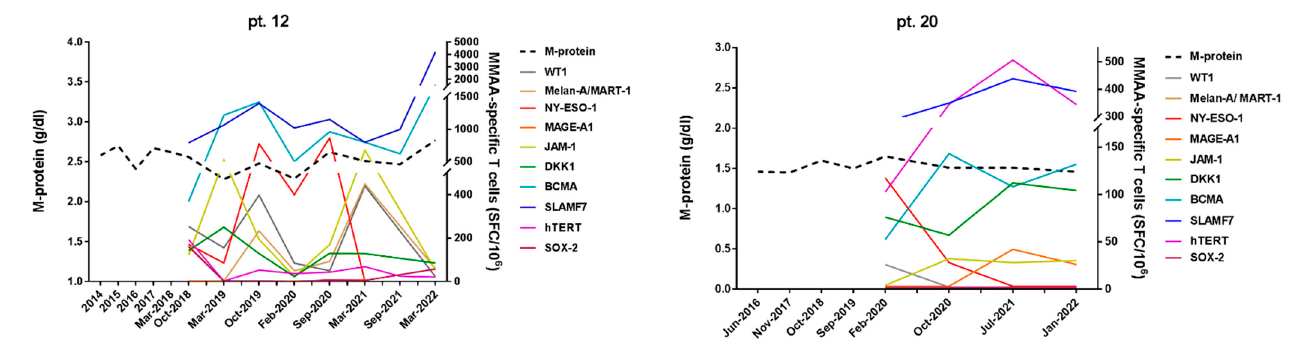
Figure 2. Correlation between MMAA-specific T-cell responses and disease course in two patients with stable monoclonal gammopathy. In these graphs, frequencies of IFN γ -secreting antineoplastic T cells targeting the different MMAAs (right, y -axis; colored continuous lines), as assessed in PB samples, at different time-points of follow-up ( x -axis), are correlated with M-protein levels (left, y -axis; black dotted line). Different y -axis scales are applied in the graphs, according to patient’s dataset. Left panel : a 79-year-old woman (pt. 12), diagnosed with IgG-kappa MGUS (intermediate-high risk) in 1998, has been showing persistently elevated—but remarkably stable—M-protein levels (i.e., ranging 2.23–2.78 g/dl), throughout the last 20 years of follow-up. By analyzing several time-points over the last 4 years, we invariably detected high frequencies of different myeloma-specific T cells, responding to almost all the antigens tested (in particular, very elevated towards SLAMF7 and BCMA). Right panel : a 63-year-old woman (pt. 20), with low-risk IgA-kappa SMM since 2016 (BM PCs 30–40%, FLC ratio 7.85, no bone lesions), showed a fully stable disease during >5-year follow-up, with M-protein levels ranging 1.43–1.65 and no occurrence of MM-defining events. Robust myeloma-specific T-cell responses were always documented in all four consecutive tests performed between 2020 and 2022. In this case, specific T-cell responses were directed to three MMAAs (namely, SLAMF7, hTERT, and BCMA).